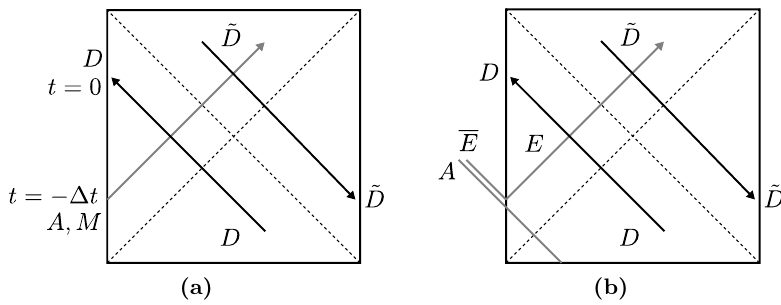
Figure 10 . (a) The e(cid:11)ect of an apparatus M . (b) The protocol from section